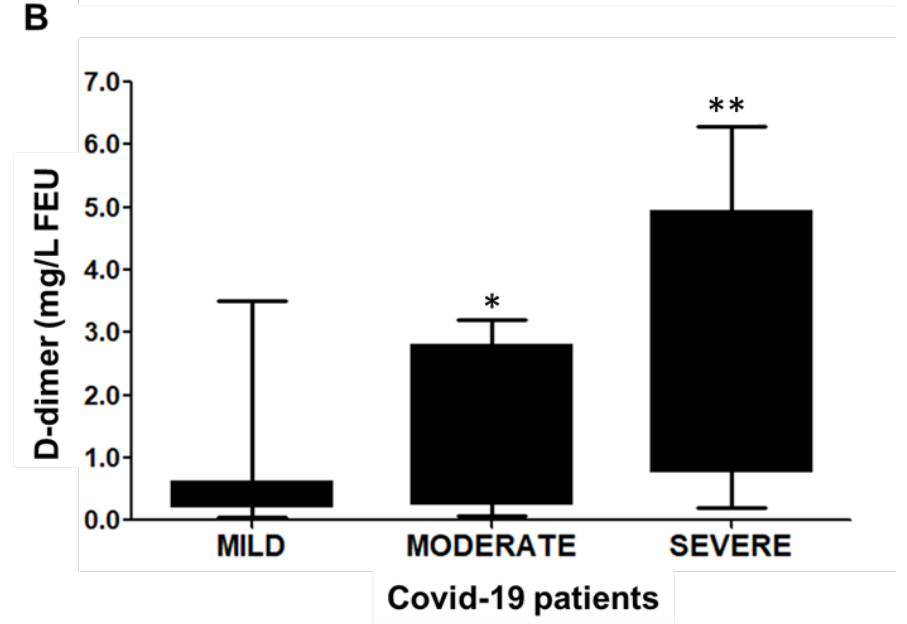
Figure 1. D-dimer in COVID-19 patients. The graphs represent the D-dimer concentration in mg/L FEU ± SD. ( A ) D-dimer levels in the blood samples of COVID-19 patients ( n = 148) and in never- infected human subjects (NHS, n = 309 A * p = 0.0027 were obtained in COVID-19 vs. NHS. A comparison analysis was carried out using the Mann–Whitney test. ( B ) D-dimer levels in COVID-19 patients with mild ( n = 66), moderate ( n = 48), and severe ( n = 34) infection were highly significant with a, * p < 0.05 (95% CI − 2.285 to − 0.04205) vs. mild infection; ** p < 0.05 (95% CI − 2.591 to − 0.1751) vs. moderate infection; and ** p < 0.001 (95% CI −3.243 to −1.850) vs. severe infection. Box and Whisker show the Min to Max values with median ±SD. Comparison analysis was performed via the one-way ANOVA method, followed by Tukey’s post hoc test.